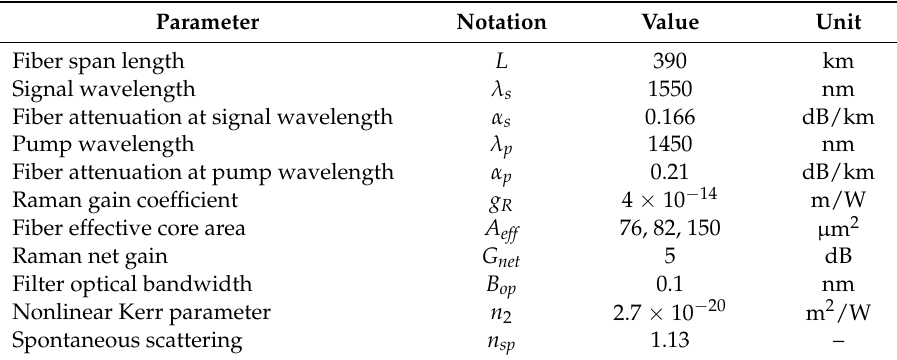
Table 1. List of parameters.